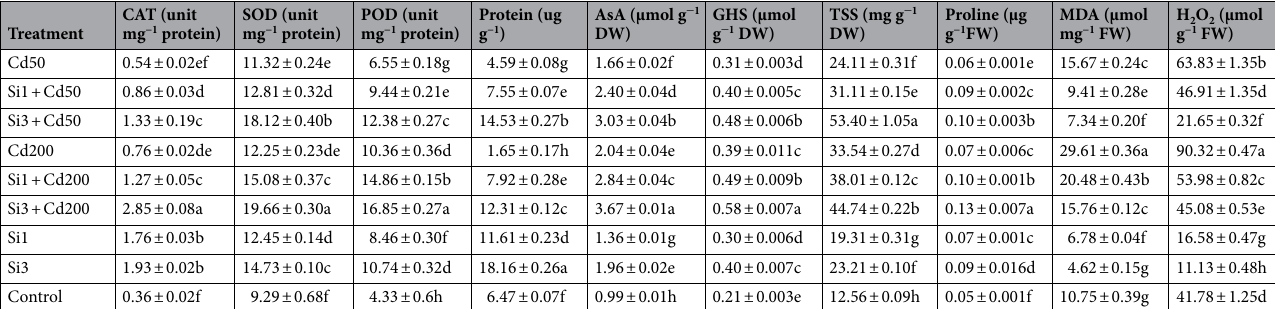
Table 1. Effect of three different levels of Si (0, 1 and 3 mmol L −1 ) on protein, enzymatic and non-enzymatic antioxidants and reactive oxygen species of cadmium (50 and 200 µmol L –1 )-stressed wheat plants. Where CAT, SOD, POD, GHS, TSS, AsA, MDA, and H 2 O 2 stand for catalase, superoxide dismutase, peroxidase, glutathione, total soluble sugar, ascorbic acid, malondialdehyde, and hydrogen peroxide, respectively. Means ± S.D. (n = 3) with different letters in the column indicates significant ( P ≤ 0.005) differences between